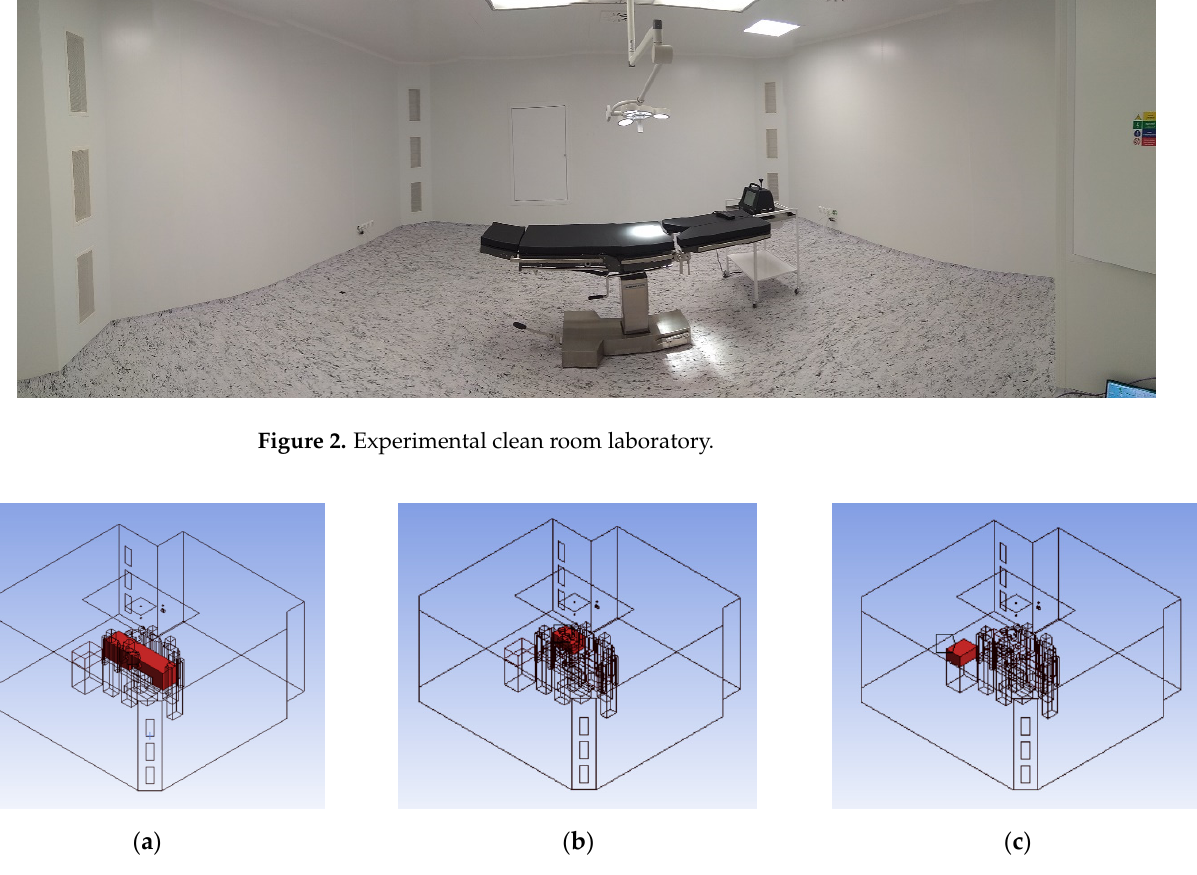
Figure 2. Experimental clean room laboratory.